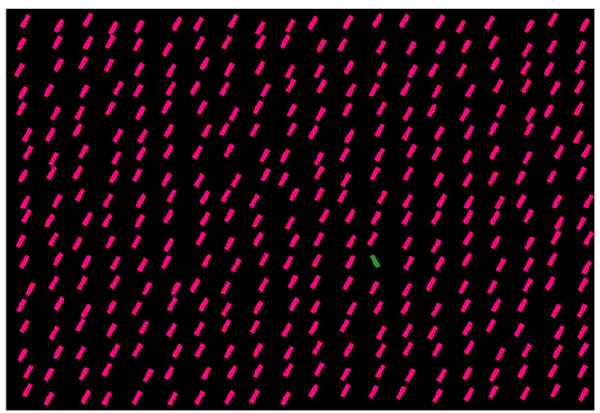
Figure 1. A schematic example of the search stimulus by Koene and Zhaoping [ 10 ] . Data in their behavioral study are used for the current study. Observers searched for a bar unique in color (C), orientation (O), or motion direction (M), or a combination of these features. In this illustration, the target is a double feature CO target, unique in both color and orientation. See Method or the original paper [10] for the actual stimulus details.